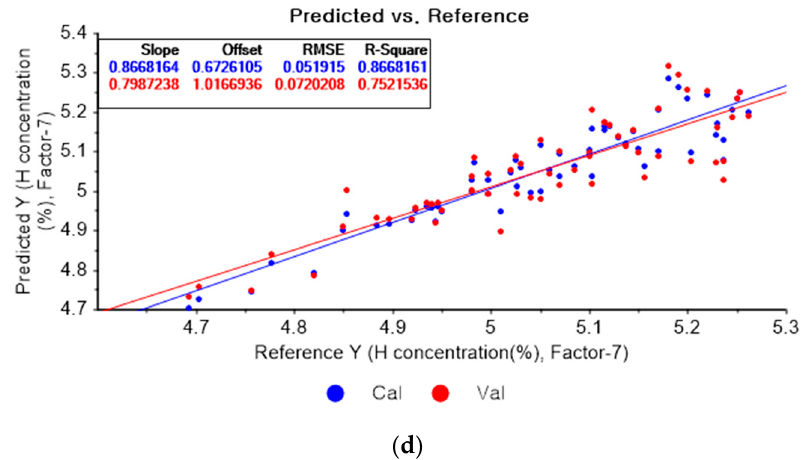
Figure 7. PLSR model of hydrogen concentration with ( a ) original data and PLSR models pre-processed by SG smoothing using ( b ) first-order polynomial with one point, ( c ) first-order polynomial with three points, and ( d ) first-order polynomial with five points.